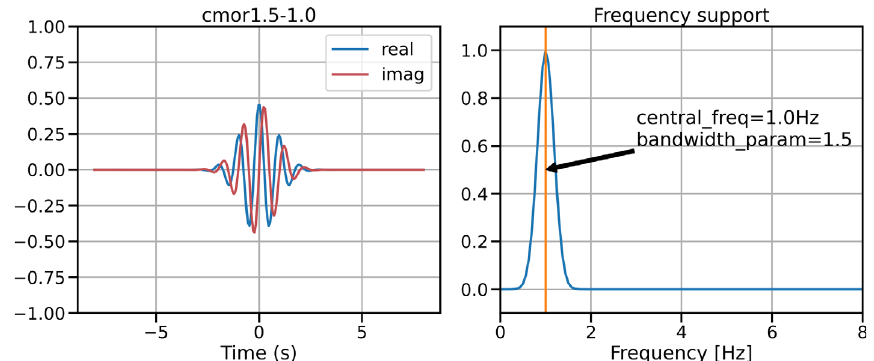
Fig. 4. Complex Morlet wavelet function used in this pipeline and its frequency